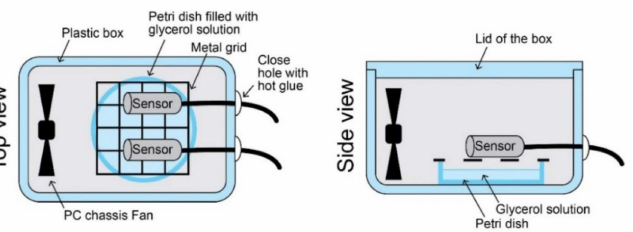
Figure 2. Schematic representation of the calibration setup for RH with AM2315